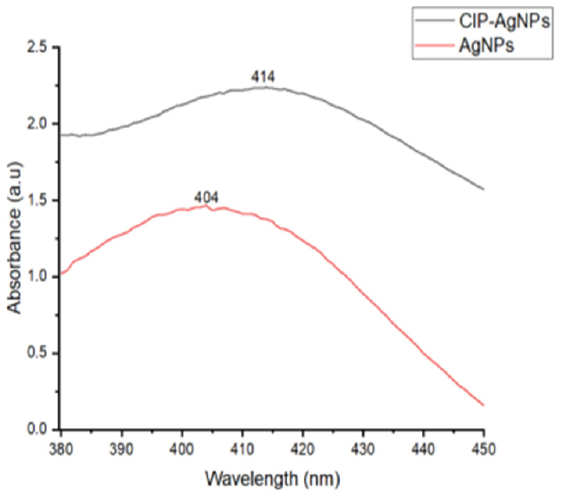
Figure 1. UV- Spectrograph of AgNPs & CIP-AgNPs.